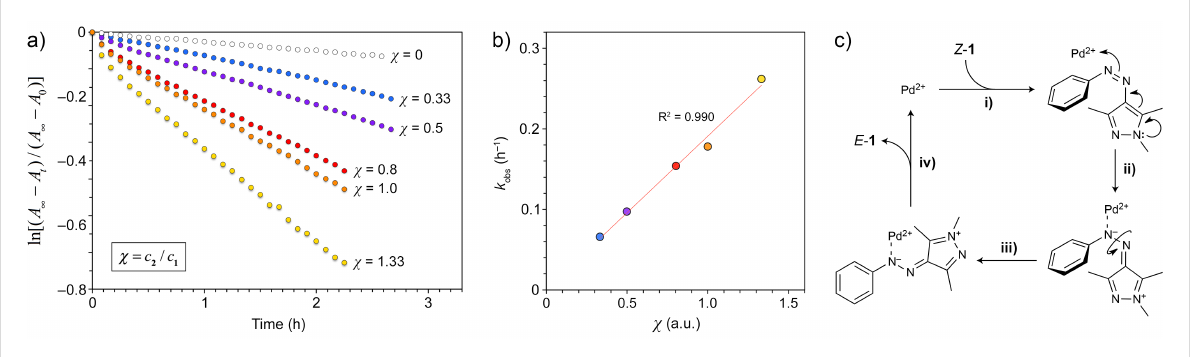
Figure 8: Palladium-accelerated back-isomerization of Z - 1 . a) Kinetics of the thermal back-isomerization of Z - 1 ( c = 0.187 mM) in the presence of in- creasing concentrations of 2 ( A ∞ denotes the absorbance at λ max before irradiation; A 0 – immediately after exposure to UV light; A t – after thermal re- laxation for time t ). b) Cage concentration dependence of the pseudo-first-order rate constant k obs . c) The proposed mechanism underlying the Pd 2+ - accelerated back-isomerization of Z - 1